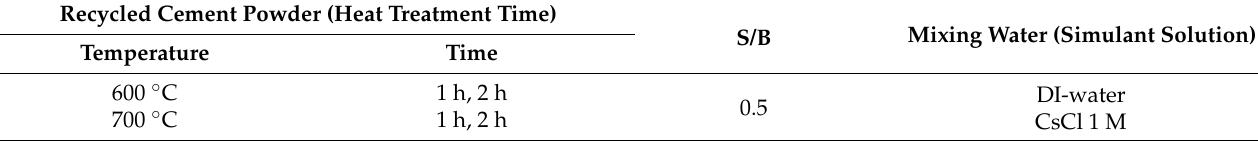
Table 2. Test protocol for wasteform specimens with recycled cement